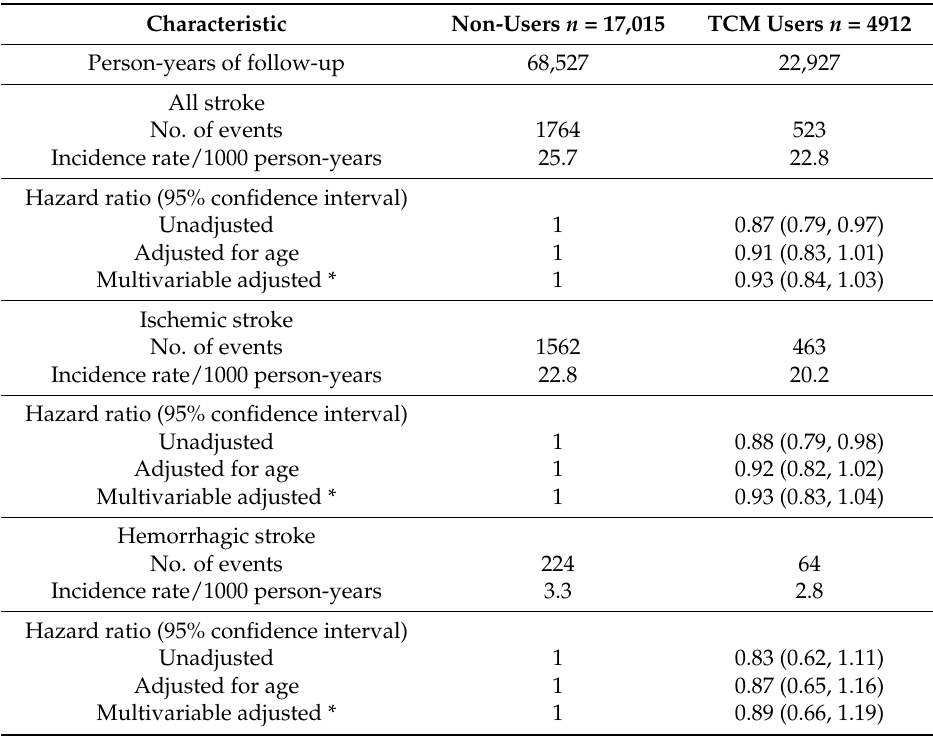
Table 2. Incidence rate and hazard ratio of incidence of stroke associated with TCM use.